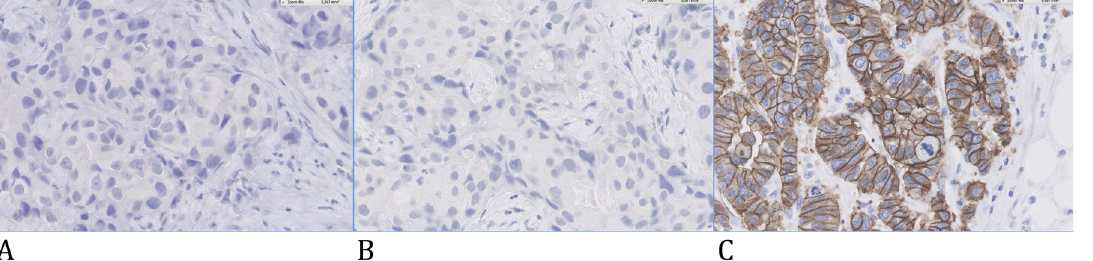
Fig 4. IHC picture of one discordant case for HER2 status. Patient (A) was IHC-negative/MapQuant-negative. Patient (B) was IHC-negative/MapQuant- positive. Patient (C) was IHC-positive/MapQuant-positive.